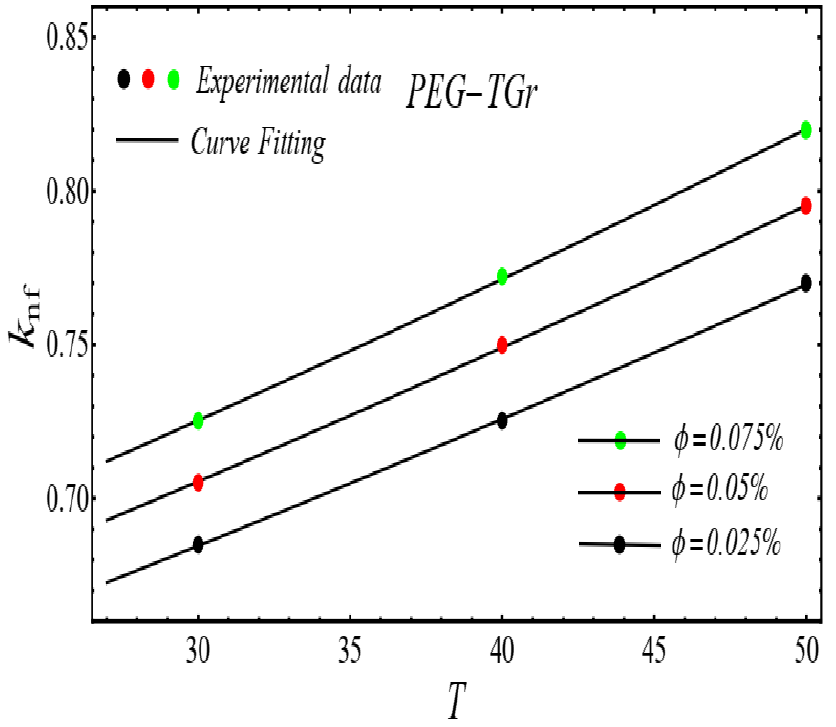
Figure 11. Fitting the Equation (4) for experimental data of PEG-TGr/DIW nanofluid at different nanoparticle volume fractions.